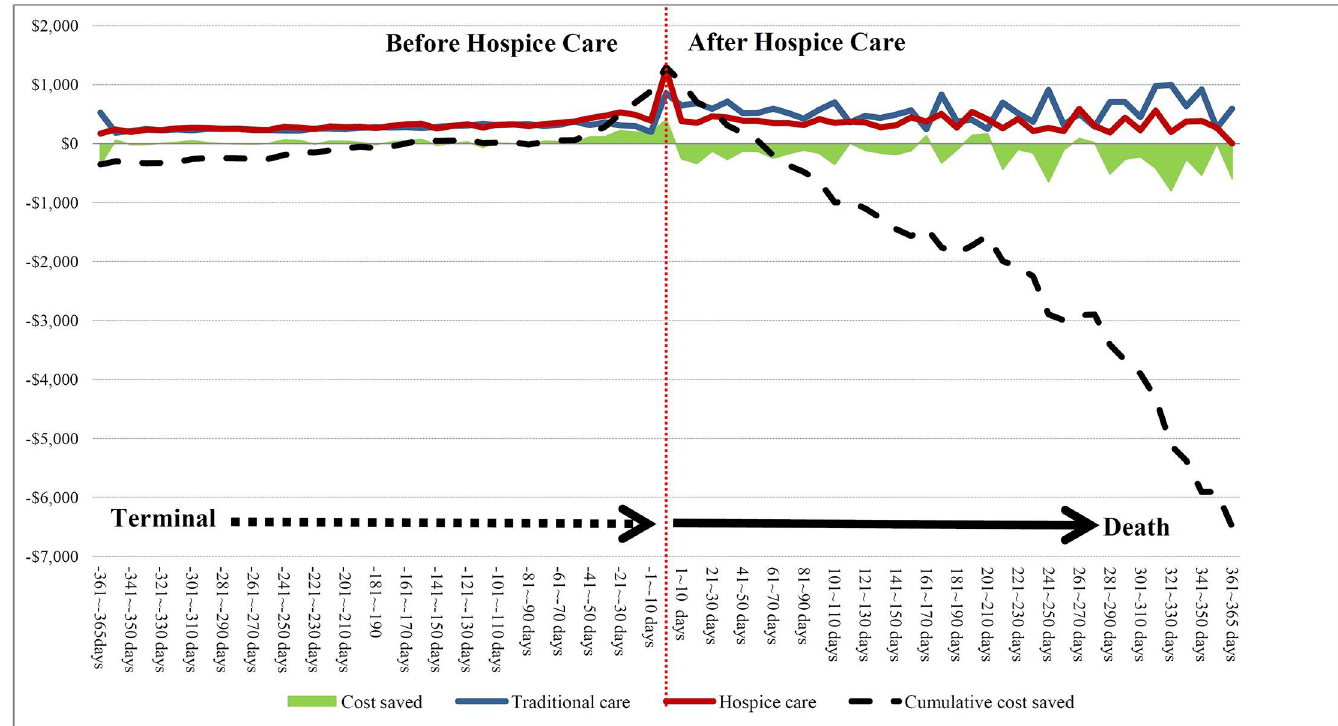
Fig 6. Trends in medical costs before and after hospice care in the year before death. The vertical dashed red line represents the day of receiving hospice care (i.e., point zero). The left side of the dashed red line represents the number of days from the beginning of the end of life to the day before accepting hospice care, and the right side of the dashed red line represents the number of days from accepting hospice care to death. The cumulative total cost for the last year was calculated regardless of the length of hospice care exposure time (e.g., terminal patients started receiving hospice care 30 days before death, while the date of death was pushed back 30 days in the traditional group for matching, and the medical cost for the two groups of patients started to accumulate to death from 335 days before receiving hospice care/ treatment). 1 US dollar = 31 Taiwan dollars.